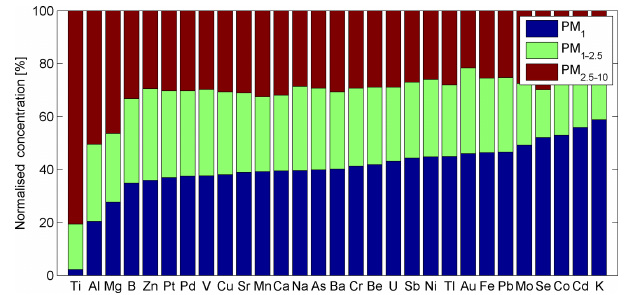
Figure 3. Mean size distributions of individual trace metal species detected. Species are arranged by increasing concentration in the PM 1 size